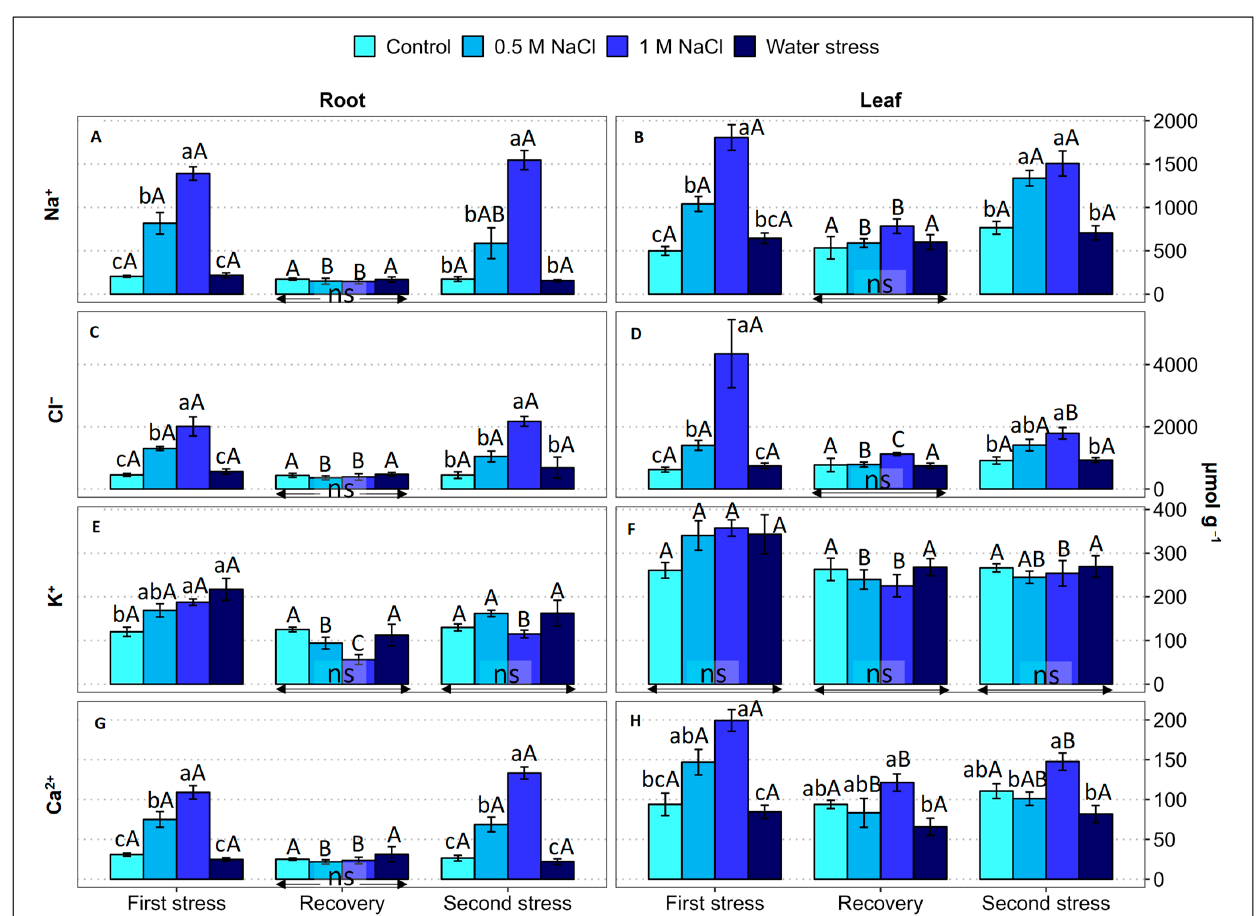
Figure 4. Effect of 30 days of stress treatment (First stress), followed by 15 days of watering with non ‐ saline water (Recovery) and by additional 15 days of stress (Second stress) on the root and leaf concentration (in μ mol g −1 DW) of ions, in Limonium angustebracteatum plants: ( A , B ) sodium (Na + ), ( C , D ) chloride (Cl − ), ( E , F ) potassium (K + ) and ( G , H ) calcium (Ca 2+ ). Different lowercase letters over the bars indicate significant differences between treatments (Control, 0.5 M NaCl, 1 M NaCl, and Water stress) for each sampling, at p ≤ 0.05; ns: non ‐ significant. Different uppercase letters indicate significant differences between the three sampling times (First stress, Recovery, and Second stress) for each treatment, at p ≤ 0.05; NS: non ‐ significant. Vertical bars indicate standard error (n = 4).